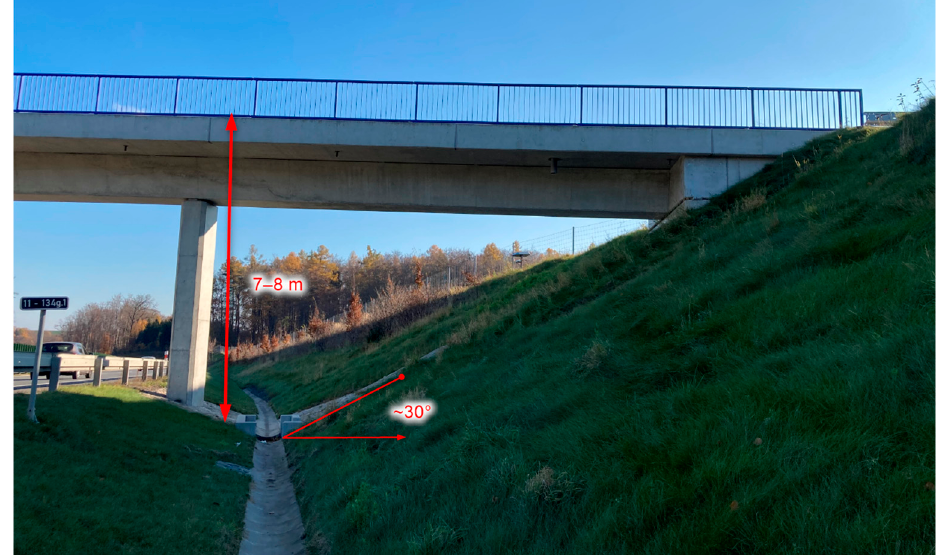
Figure 2. Locality near Hrabyn ě – Josefovice and bridge 11 - 134G.